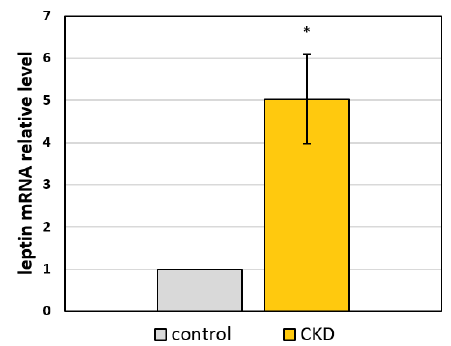
Figure 3. The relative mRNA level of leptin in 3T3-L1 adipocytes cultured for 48 h with a set of FAs extracted from the serum of control subjects (control) or patients with stage 5 CKD (CKD). * p < 0.05 compared to the control. Data are presented as the means ± SD. All experiments were run in three independent attempts.